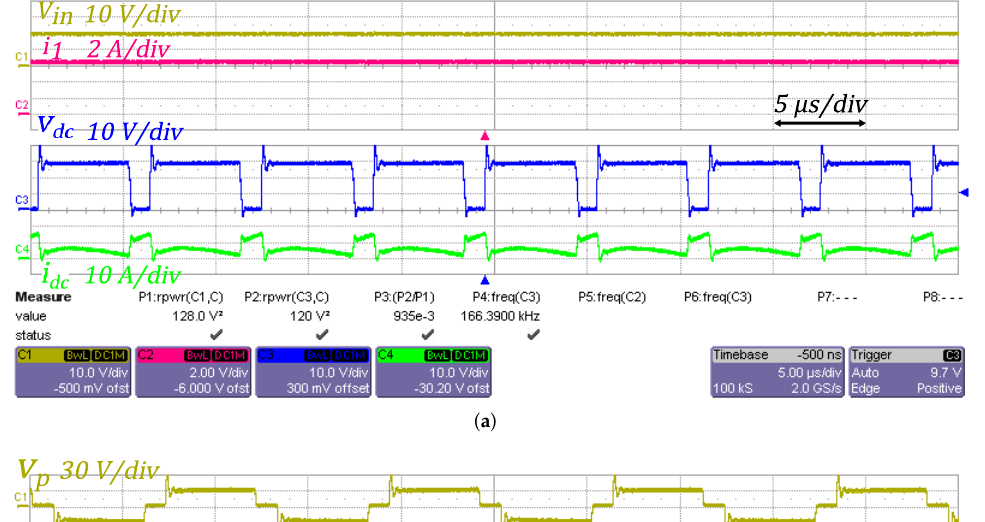
Figure 8. Experimental waveforms of the qZS-IPT system in boost mode with D = 0.1. ( a ) Input voltage V in and current i 1 , DC − link voltage v dc and current i dc . ( b ) primary side voltage v p and current i p , secondary side voltage v s and current i s . ( c ) Input voltage V in and current i 1 , output voltage V o and current I o .